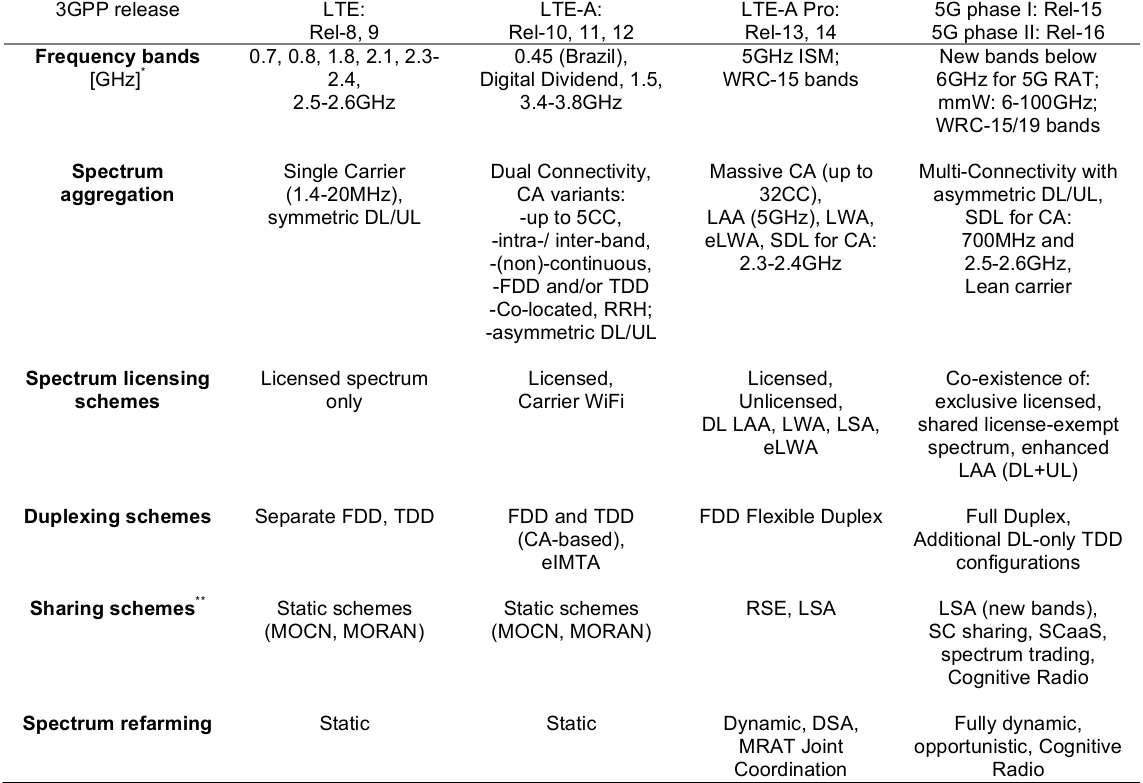
Table 2. Spectrum Toolbox evolution across LTE